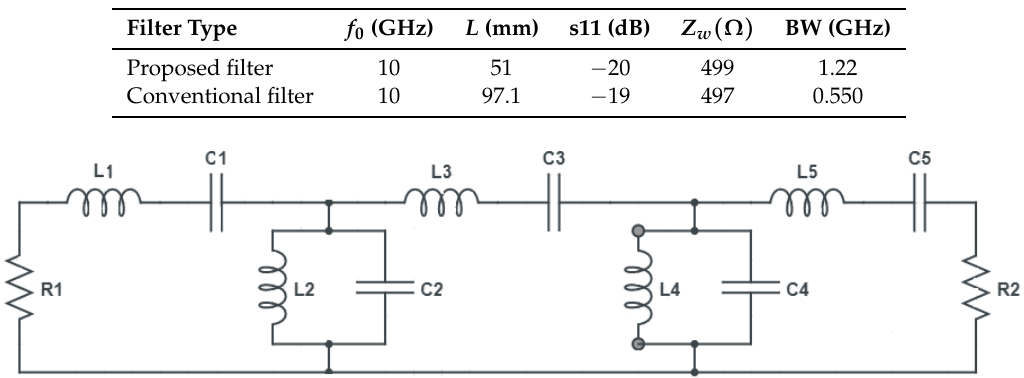
Figure 17. Circuit model of a symmetrical bandpass filter for the Chebyshev response after transformation from low pass prototype filter, R 1 = R 2 = 498 Ω , C 1 = C 5 = 0.002644 pF , C 2 = C 4 = 0.6932 pF,